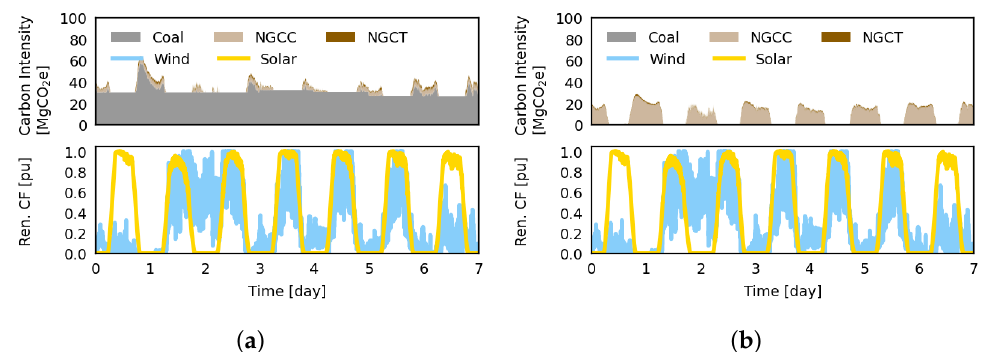
Figure 9. Example week of economic dispatch carbon intensity for a high renewable capacity factor weeks with ( a ) coal-dominant support and ( b ) natural gas-dominant support, respectively. Large spikes in carbon intensity occur in response to renewable power fluctuation. Quick spikes appear to peak and meet demand which can be compensated for with short term energy storage or demand